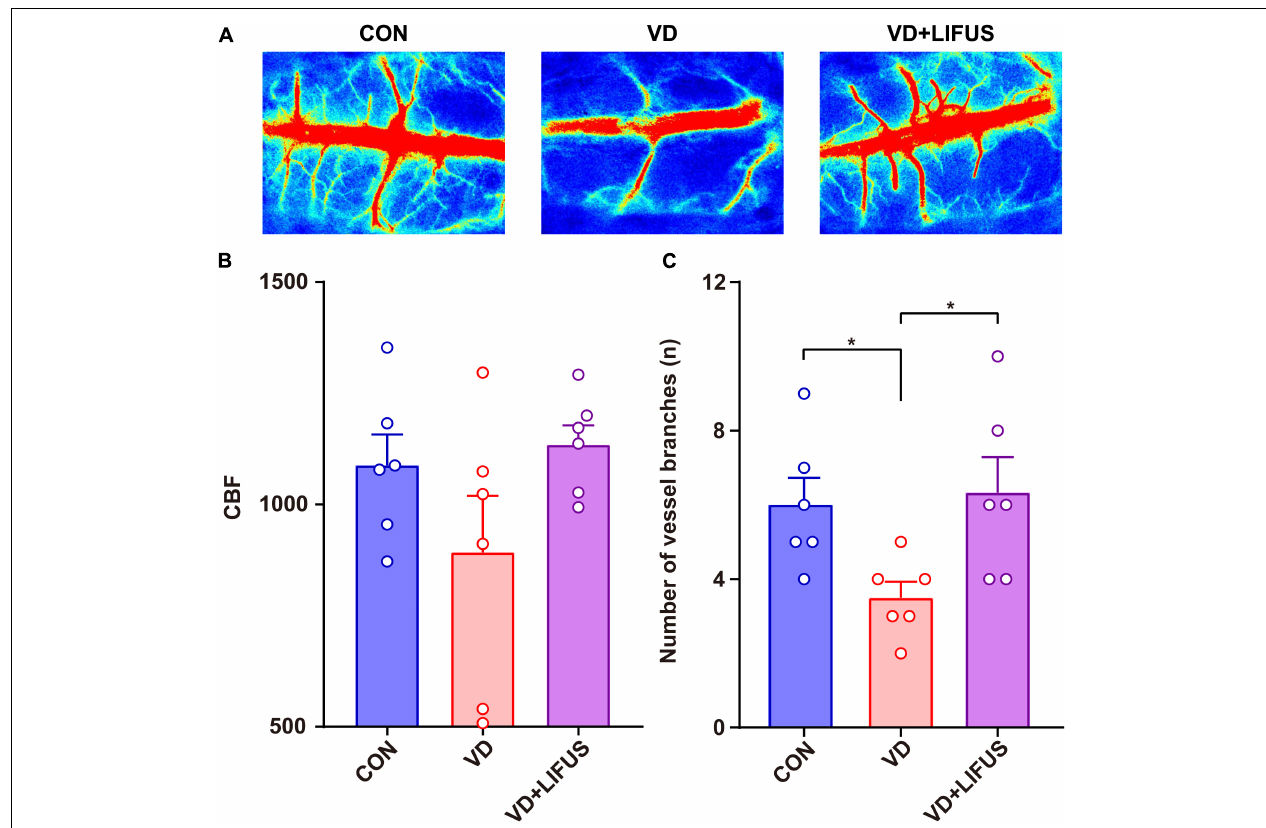
FIGURE 3 | Effect of LIFUS on blood flow in VD rats. (A) Typical diagrams of brain flow in the region of interest in three groups. (B) The average blood flow of main vein. (C) The number of vascular branches. Data are expressed as mean ± SEM. * p < 0.05 (CON, VD, VD + LIFUS, n =